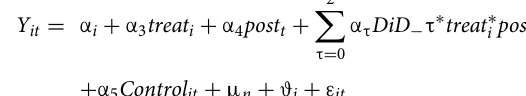
TABLE 4 Regression results of subsamples by